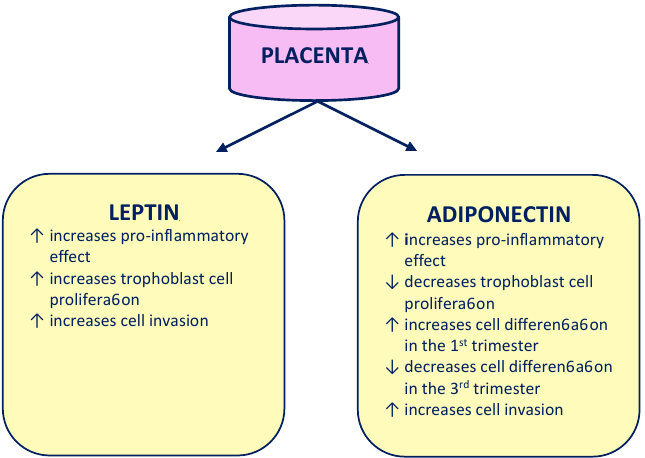
Figure 1. Role of leptin and adiponectin in the placenta.